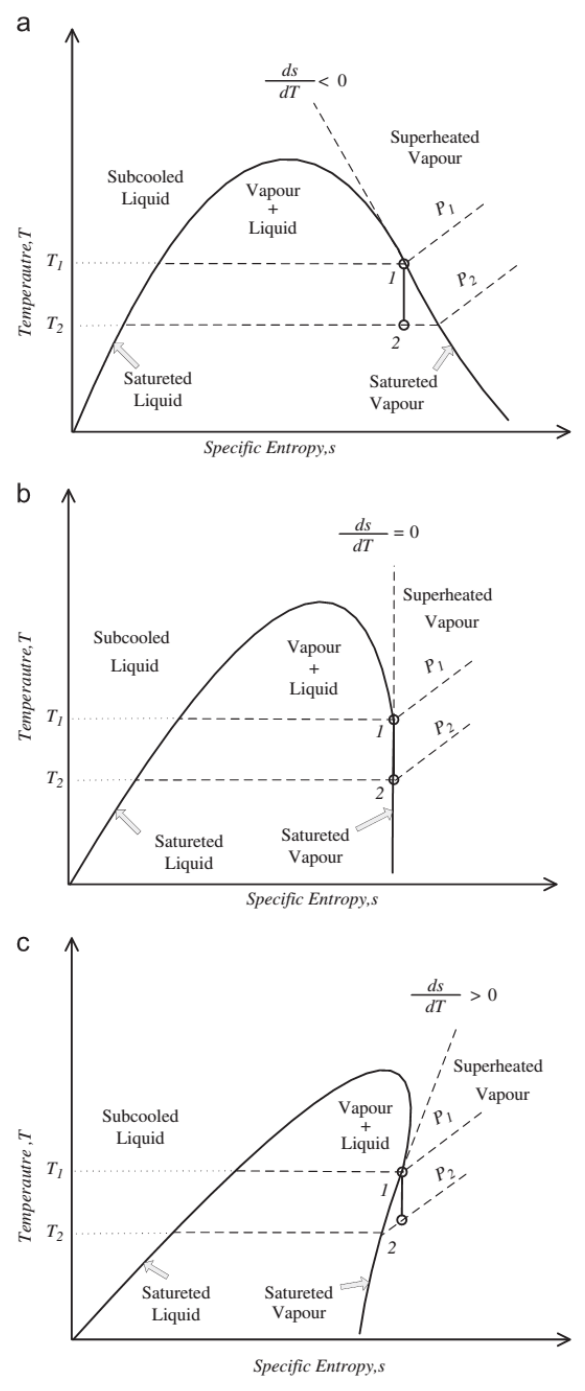
Fig. 1. Diagram T-s for fluids (a) wet, (b) isentropic and (c) dry [14] On the basis of the data collected in Table 1, it can be notice that the value of acentric factor ω rise with growth of molecular mass of working